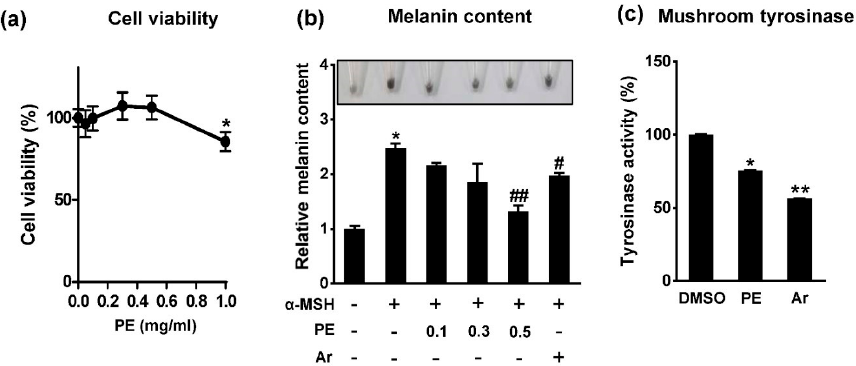
F igure 1 Figure 1. Effects of pear extract (PE) on melanogenesis in mouse melanoma cells. ( a )